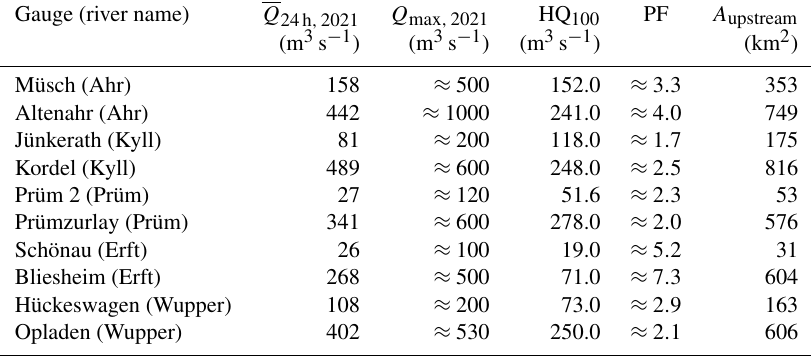
Table 1. Gauges of the 2021GD data set in the LReg area (adopted from Part 1, Table 1): Q 24h , 2021 indicates the daily mean streamflow, and Q max , 2021 is the peak discharge of the July 2021 flood event (values are estimates); HQ 100 indicates a flood with a statistical 100-year return period. The peak factor PF is defined as Q max , 2021 divided by HQ 100 . Additionally, the upstream catchment size A upstream is given.